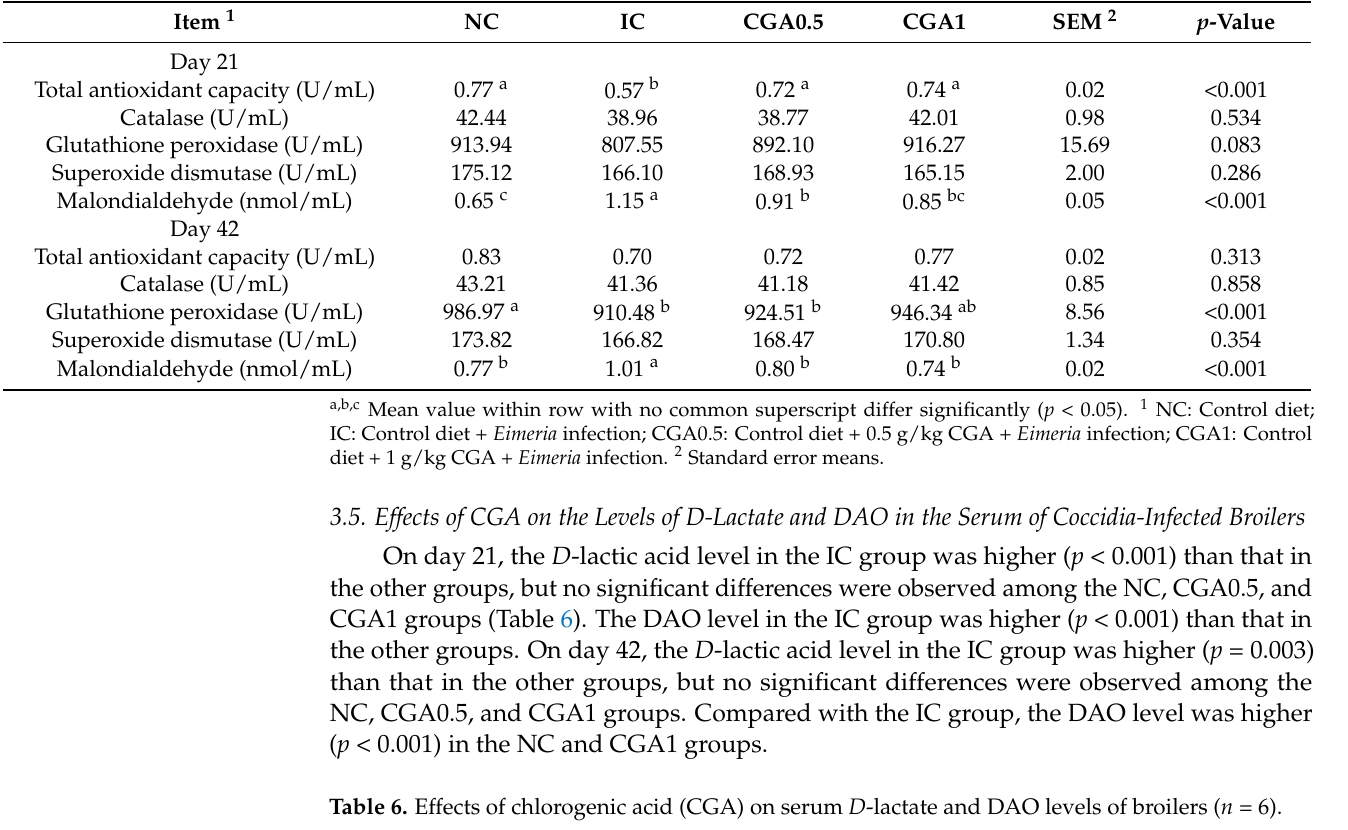
Table 5. Effects of chlorogenic acid (CGA) on antioxidant indices in the serum of broilers ( n = 6).